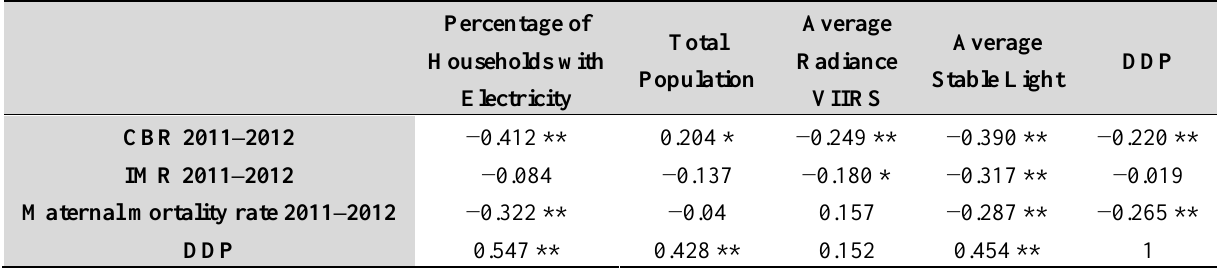
Table 4. Results of correlations between health metrics and rate of electrification, average stable lights and average radiance. VIIRS, Visible Infrared Imaging Radiometer Suite.